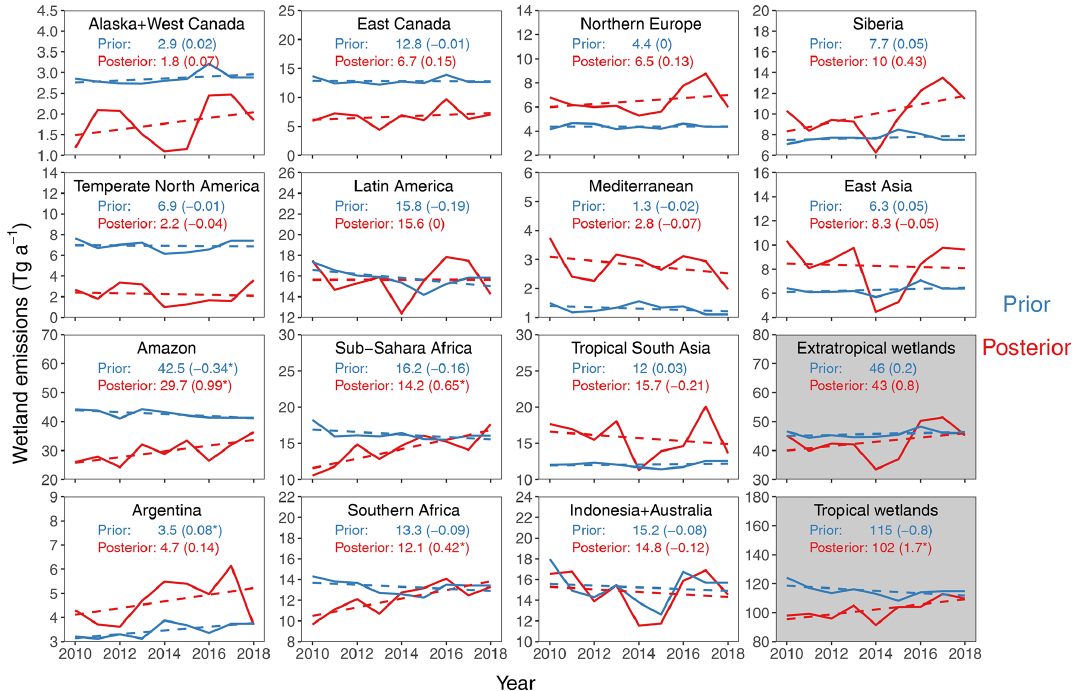
Figure 12. Wetland emission trends for 2010–2018. The figure shows annual mean emissions for the prior estimate (mean of WetCHARTs inventory ensemble) and the posterior estimate after inversion of GOSAT data. Values are for the 14 subcontinental regions in Fig. 1 (panels with a white background) and also aggregated for the extratropics and tropics (panels with a grey background). The trends are from ordi- nary linear regression. Inset are prior and posterior 2010–2018 average annual emissions (Tga − 1 ) with 2010–2018 trends (Tga − 1 a − 1 ) in parentheses. Significant trends at the 95% confidence level are denoted with *. Note the differences in scales between panels.